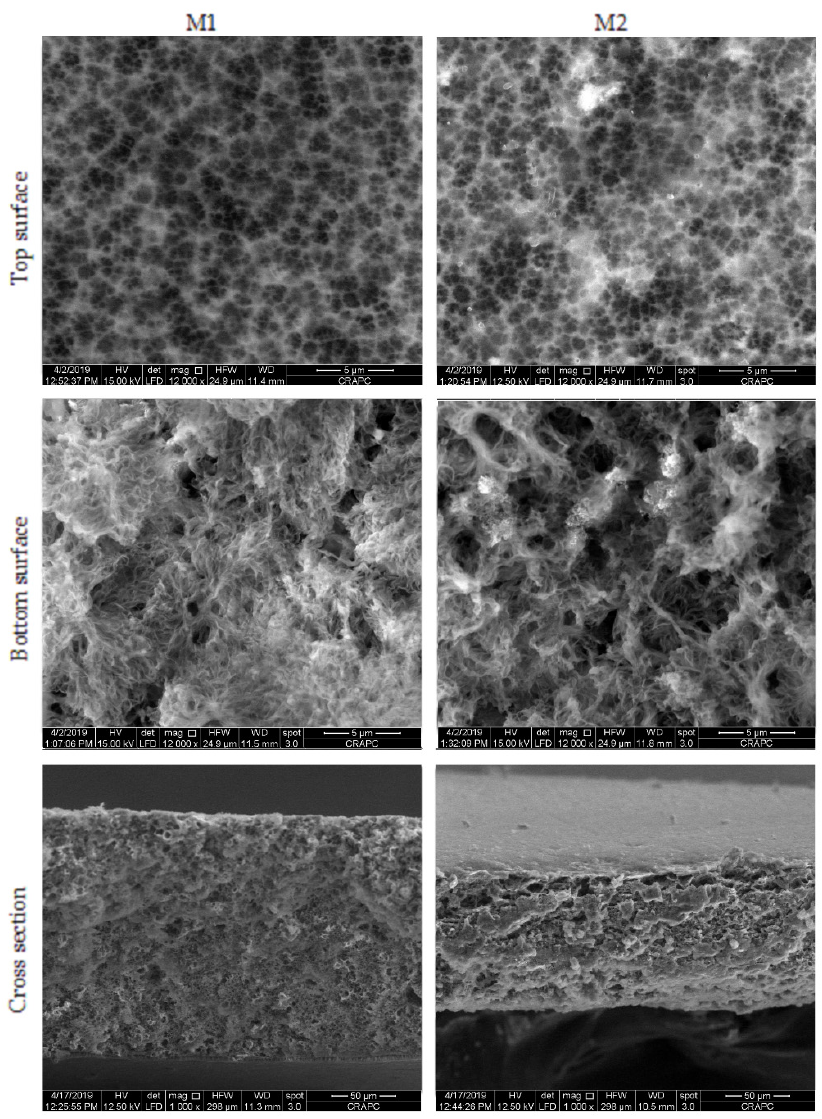
Figure 1. SEM images: top surface, bottom surface, and cross-sections of membranes M1 and M2.